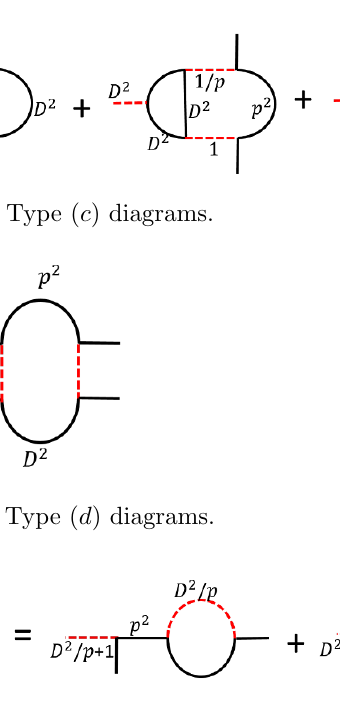
Figure 25. Type ( e )